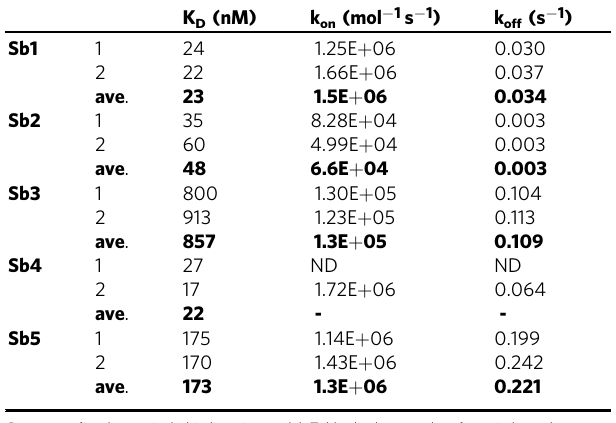
Data were fi tted to a single binding site model. Table displays results of two independent biological replicates. Their average is shown in bold ( ave. ). The bold values display the average of the two biological